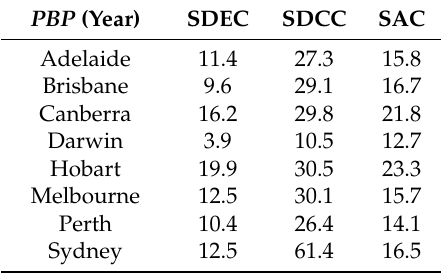
Table 13. Payback period of different solar cooling